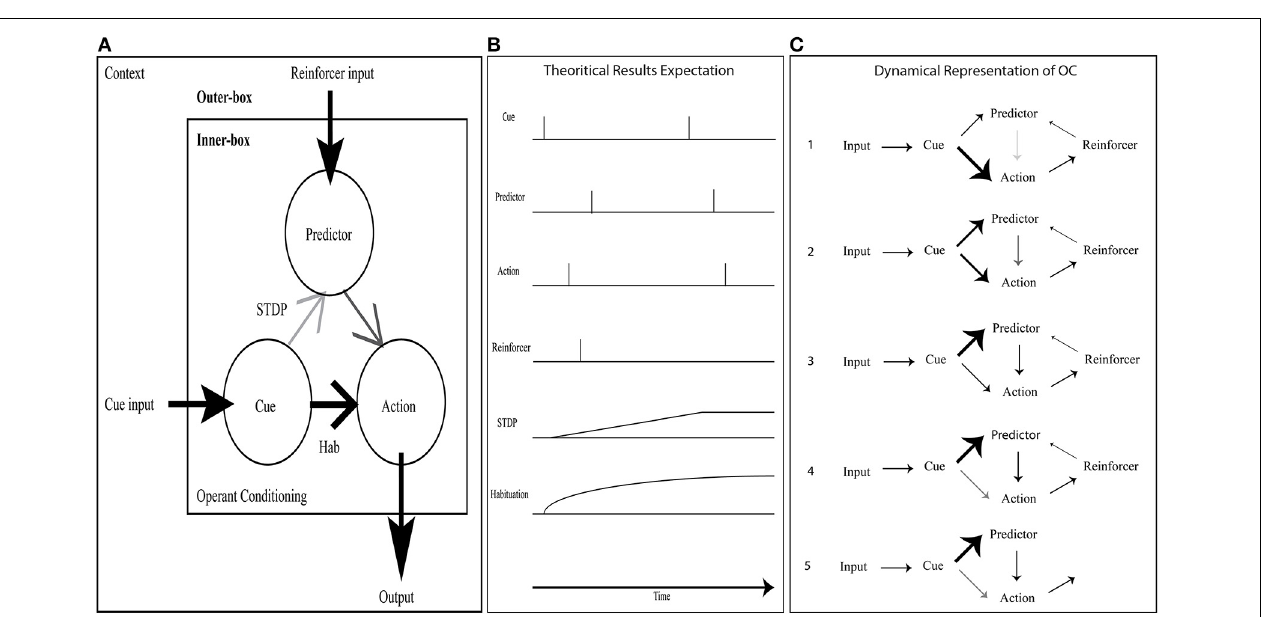
increases due to STDP learning. It eventually allows Cue alone to stimulate Predictor and from this new path Action neuron. In the contextual outer-box, the input and output can be abstracted to any type of neural structure. (B) Dynamic representation of OC with the crucial components. Using a positive reinforcer (reward), the results are simulated through a timeline: Predictor leads to an Action without any Reward. (C) Dynamic step representation of the OC learning phenomenon with an emphasis on synaptic strength